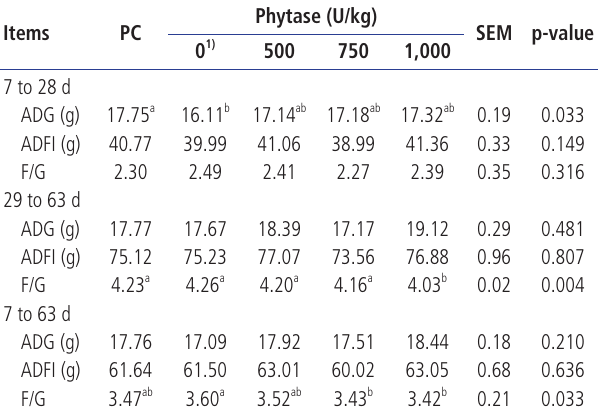
Table 2. Effects of different phytase on performance in Youxian sheldrake